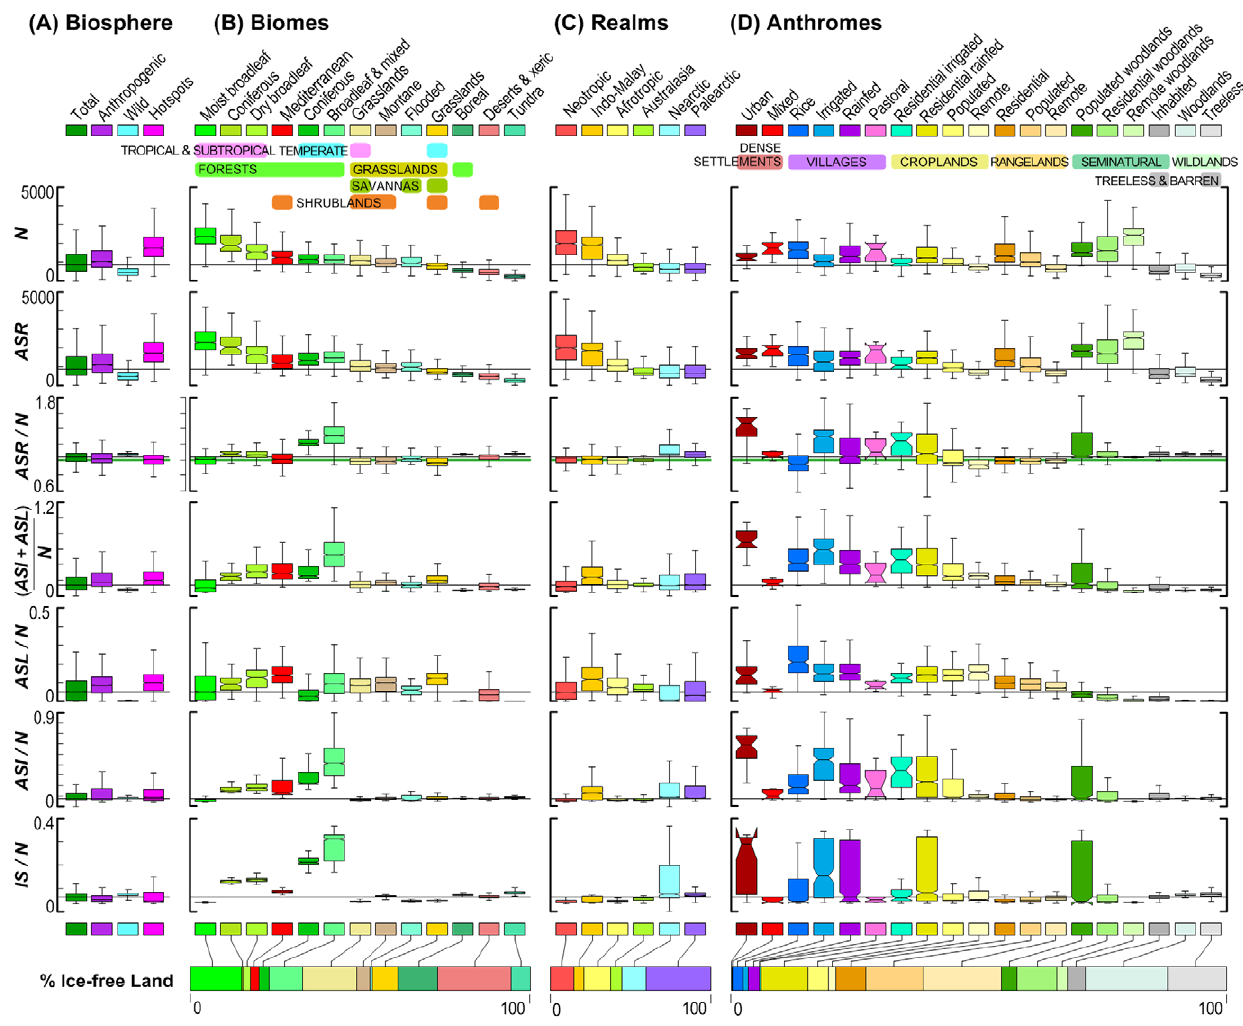
Figure 3. Global patterns of plant species richness and its changes across (A) the terrestrial biosphere, (B) biomes (C) biogeographic realms and (D) anthromes. Notch in box plots is 95% confidence interval for median; whiskers exclude outliers. Horizontal black lines are global medians; green line in ASR / N plot highlights ASR = N . Horizontal bar charts at bottom present class areas in proportion to their global area.